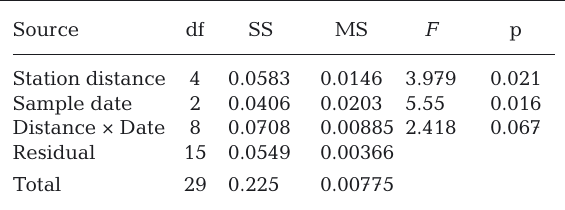
Table 6. ANOVA for cumulative mass eroded for Navy